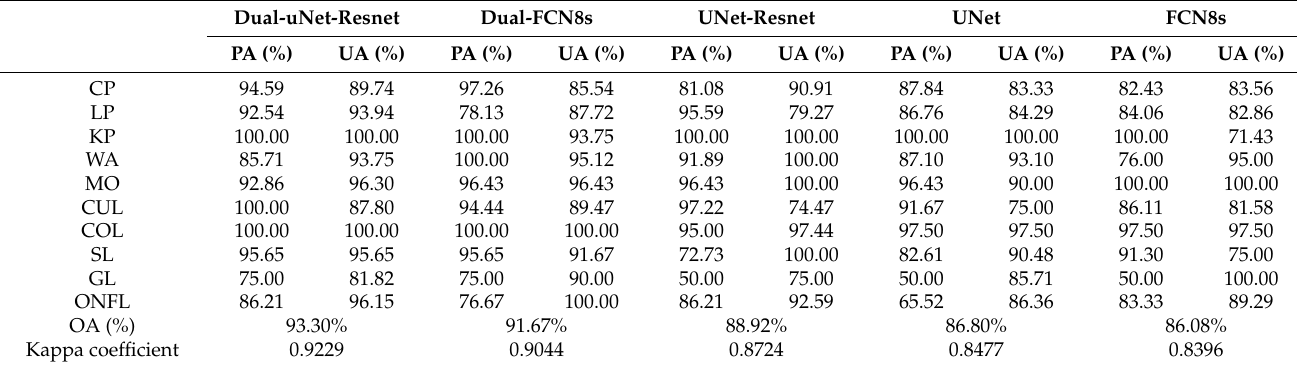
Table 4. Classification accuracies of the dual-uNet-Resnet, dual-FCN8s, UNet-Resnet, UNet, and FCN8s for the Wangyedian forest farm.